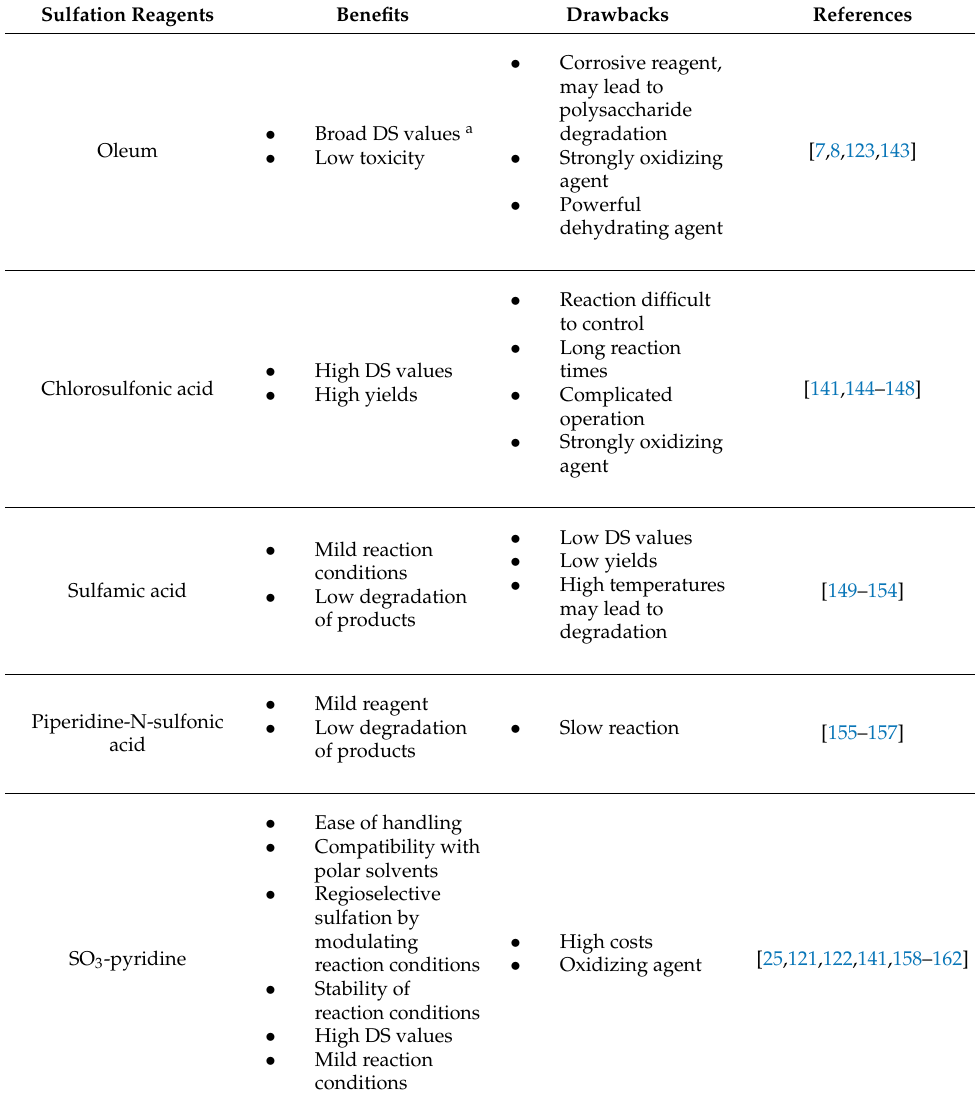
Table 2. Benefits and drawbacks of sulfation modification